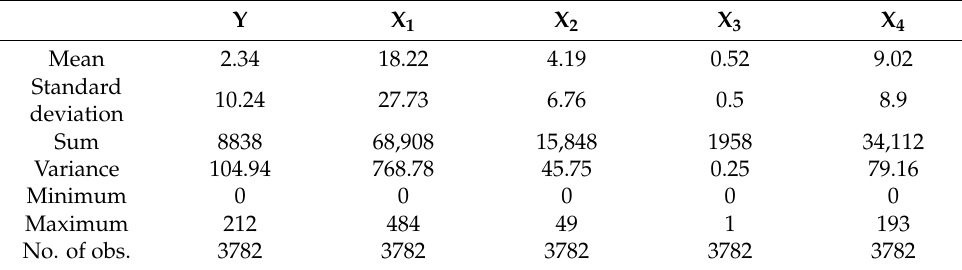
Table 3. Descriptive